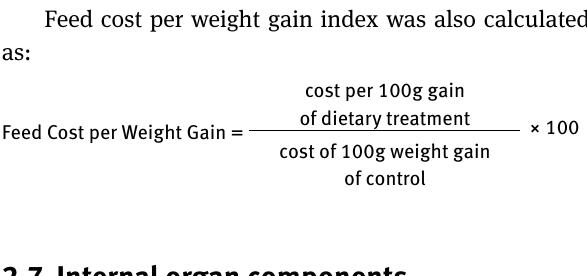
Oyster shells Vitamin/trace mineral premix